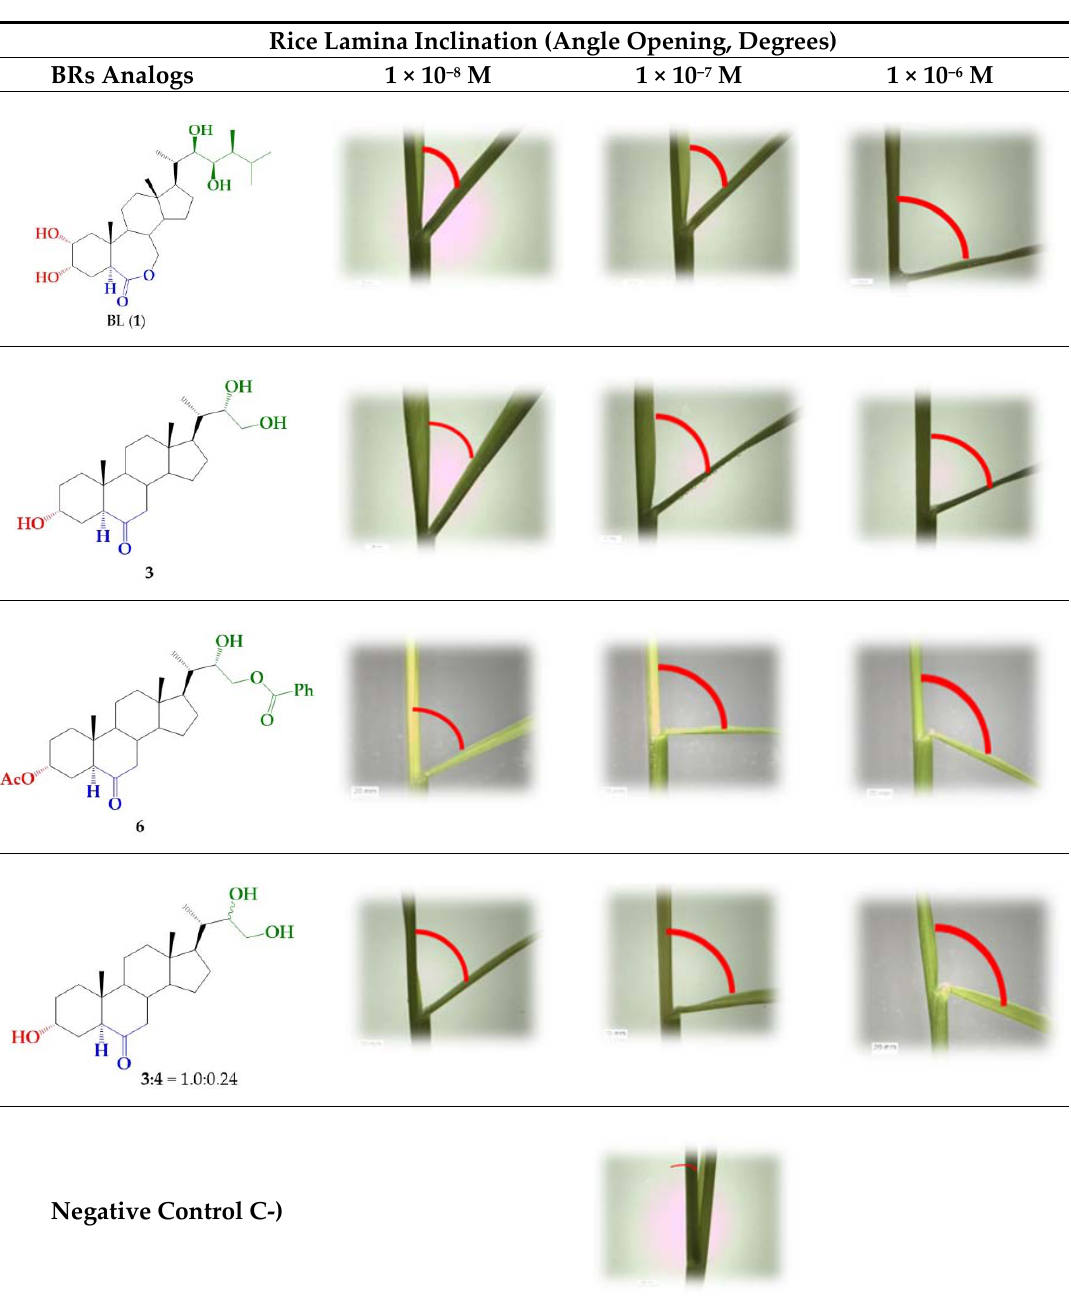
Figure 2. Rice-lamina assays using the second leaf lamina joints of excised leaf segments treated with BR analogs ( 3 and 6 ) and the epimeric mixture 3 / 4 (1.0:0.24) at different concentrations: 1 × 10 − 8 , 1 × 10 − 7 , and 1 × 10 − 6 M. BL ( 1 ) was used as positive control at the same concentrations.